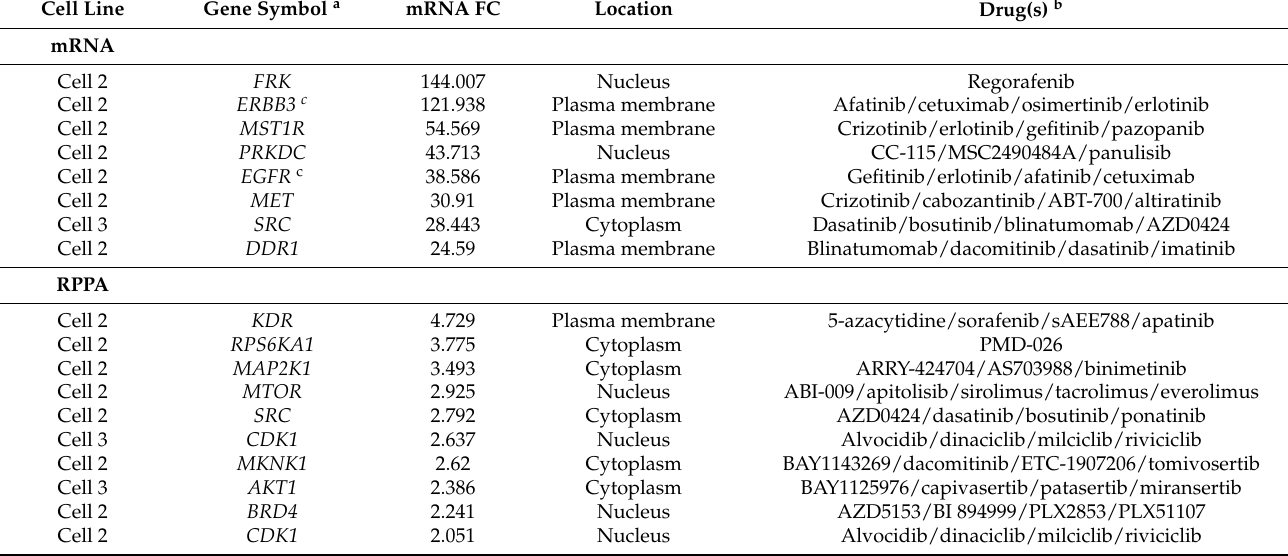
Table 5. Drugs that target receptor tyrosine kinase genes and proteins. The tyrosine kinases showed high expression levels (fold change > 2) in penile cancer-derived cells 2 and 3. Data were generated using the Ingenuity Pathway Analysis software (Qiagen, Valencia, CA, USA).